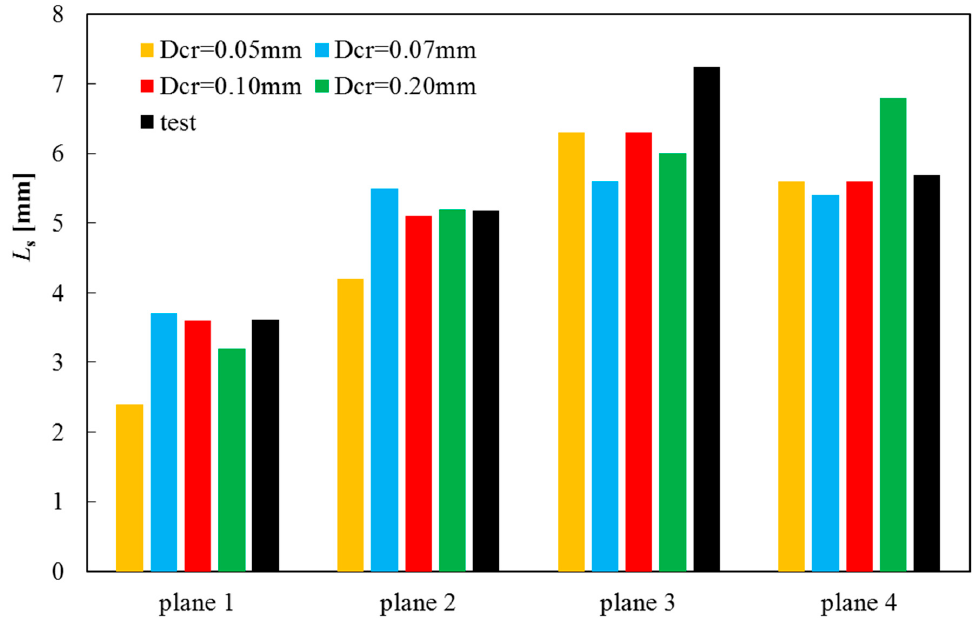
Figure 13. Spray projection segment length.